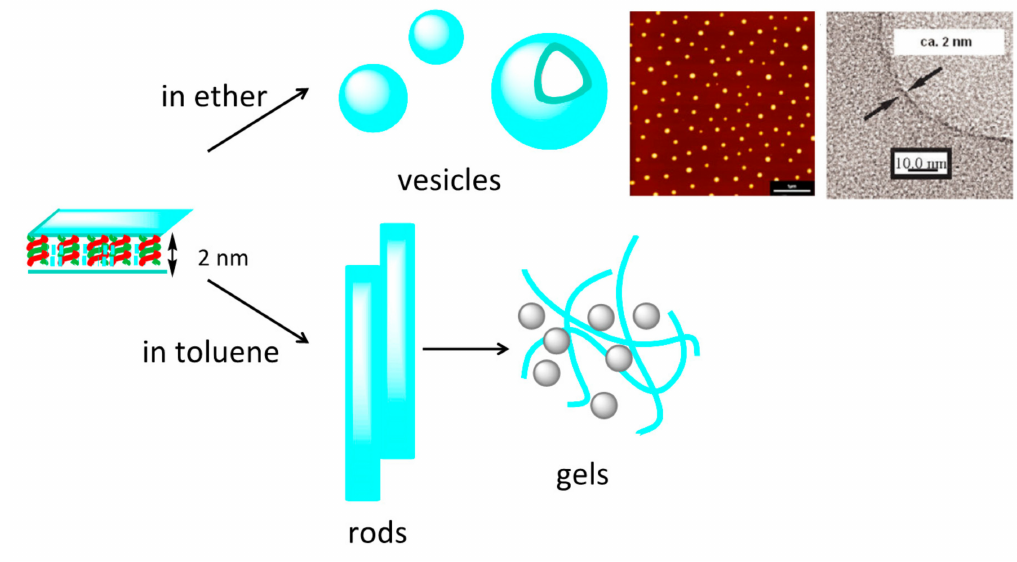
Figure 20. Effects of solvents on the morphology of self-assembly materials derived from hetero-double-helices ( P )-pentamer/( M